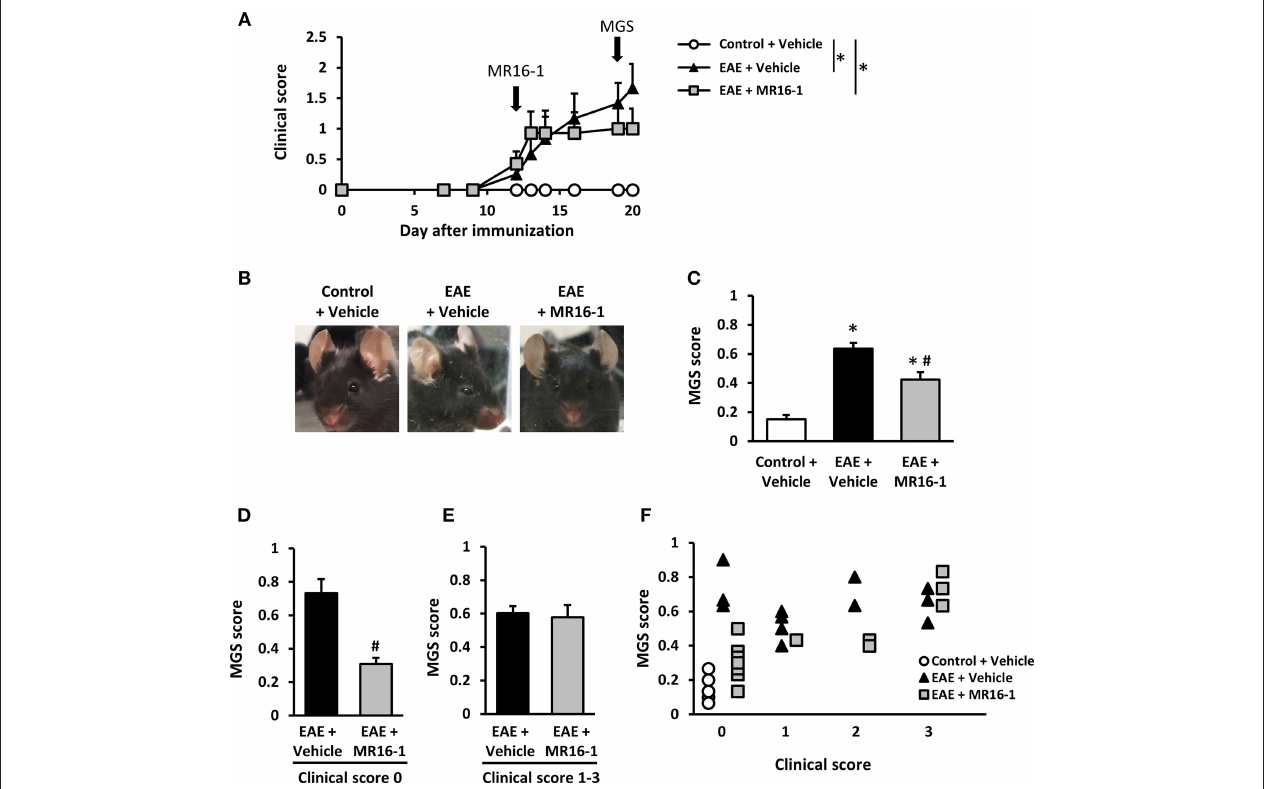
FIGURE 1 | Effects of administration of MR16-1 on facial grimacing in EAE mice. (A) Administration of MR16-1 on Day 12 did not suppress clinical score in EAE mice. Arrows indicate the timing of MR16-1 administration and MGS measurement. (B) Representative images showing facial grimacing of control and EAE mice on Day 19 after immunization. (C) Administration of MR16-1 on Day 12 significantly decreased MGS score in EAE mice on Day 19. (D–F) Administration of MR16-1 significantly reduced MGS score in pre-onset EAE mice but not in post-onset EAE mice, especially in the mice with clinical score 3. * p < 0.05 vs. Control + Vehicle, # p < 0.05 vs. EAE + Vehicle by Steel-Dwass test or Wilcoxon rank sum test ( n = 6 – 14 per